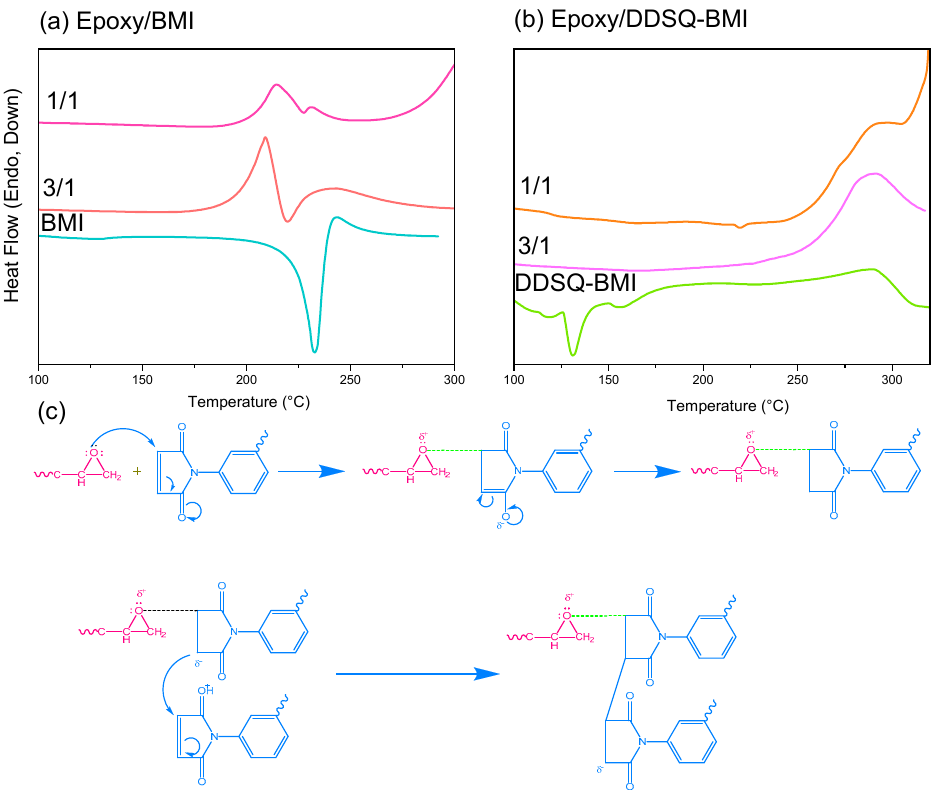
Figure 3. DSC analyses of ( a ) epoxy/BMI and ( b ) epoxy/DDSQ-BMI hybrids of first heating run, and ( c ) the thermal polymerization mechanism of epoxy with bismaleimide compound.